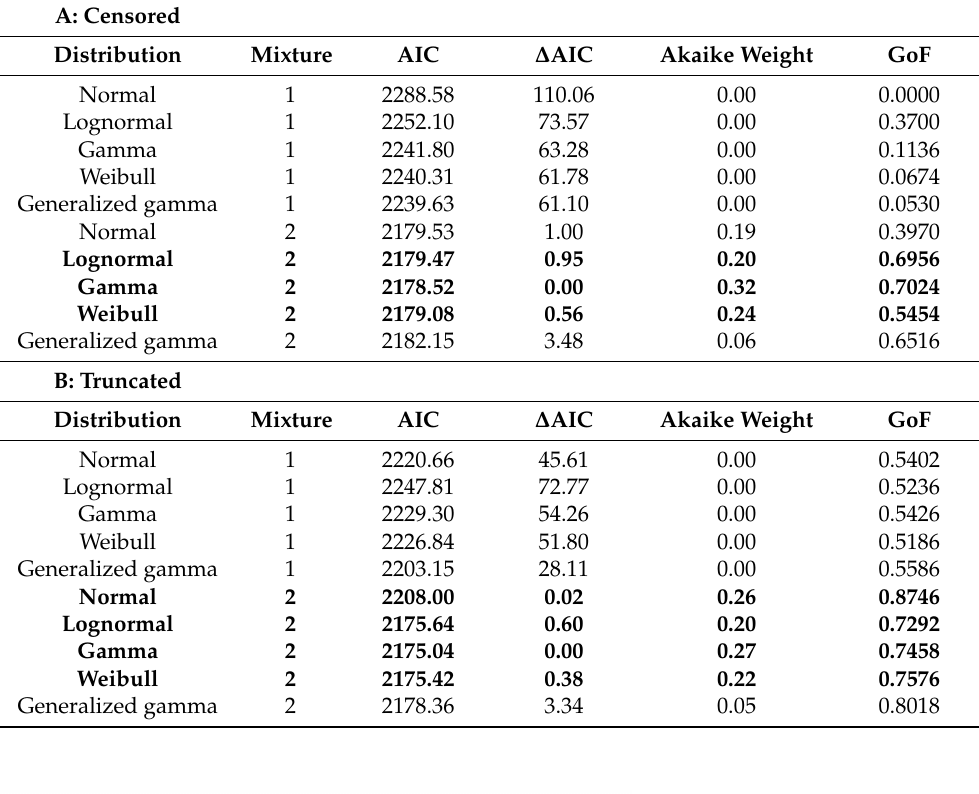
Table 1. Model selection based on Akaike information criterion (AIC), Akaike weight, and goodness of fit (GoF) for normal, lognormal, gamma, Weibull, and generalized gamma distributions applied to a set of 200 left-censored (A) or left-truncated (B) fictive data. Selected models based on a combination of Akaike weight and GoF are highlighted in bold.